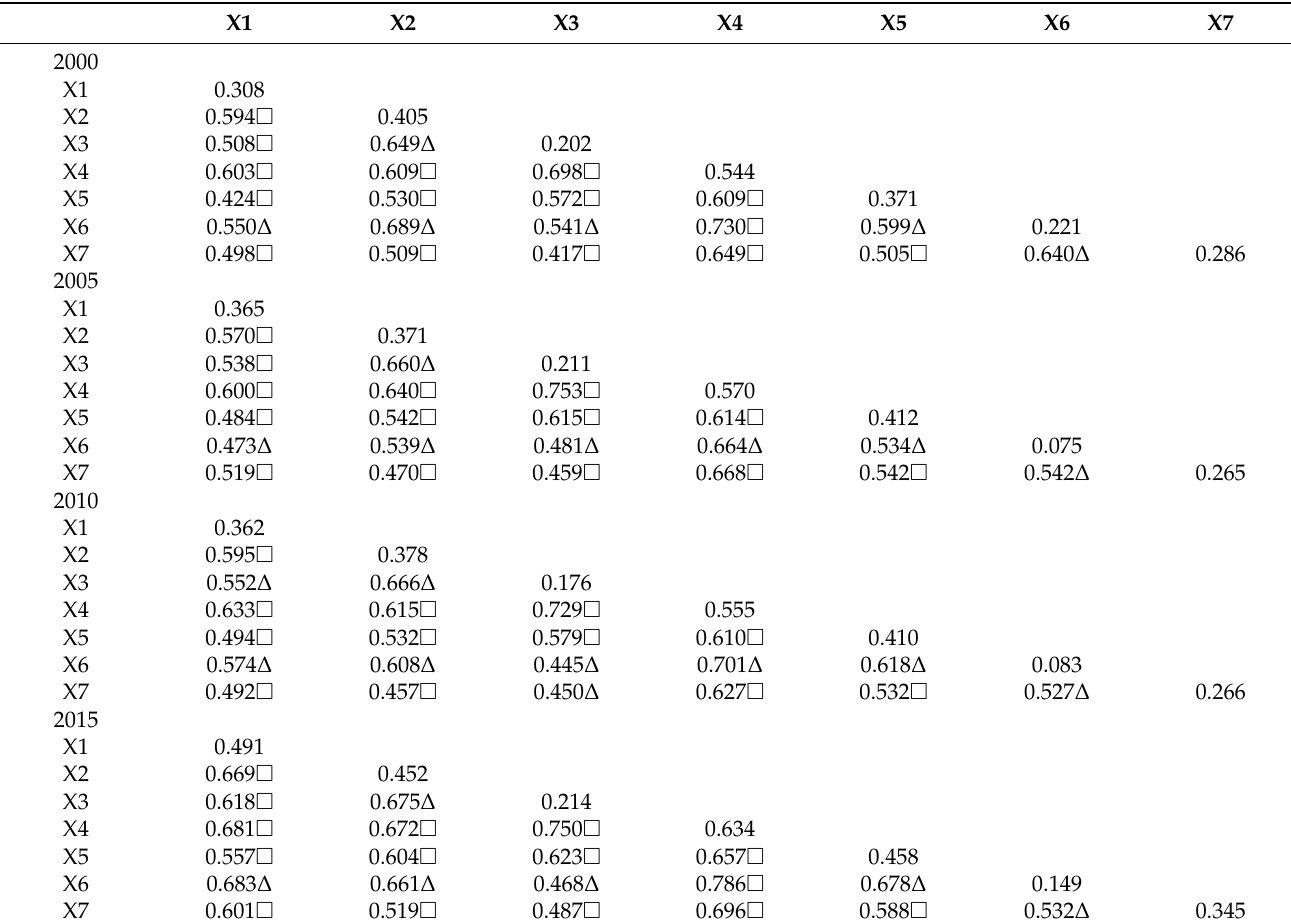
Table 3. Interaction detectors of the